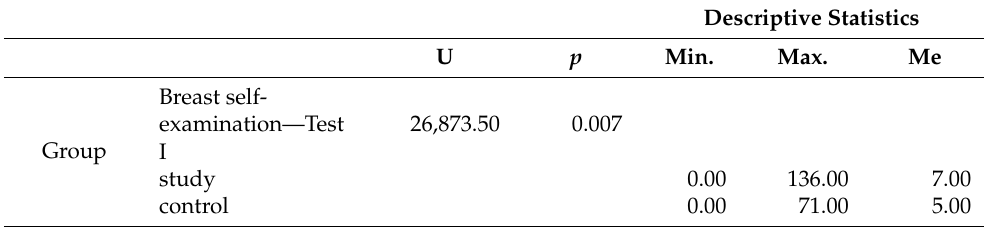
Table 4. Mann–Whitney U Test for independent trials—Test I.